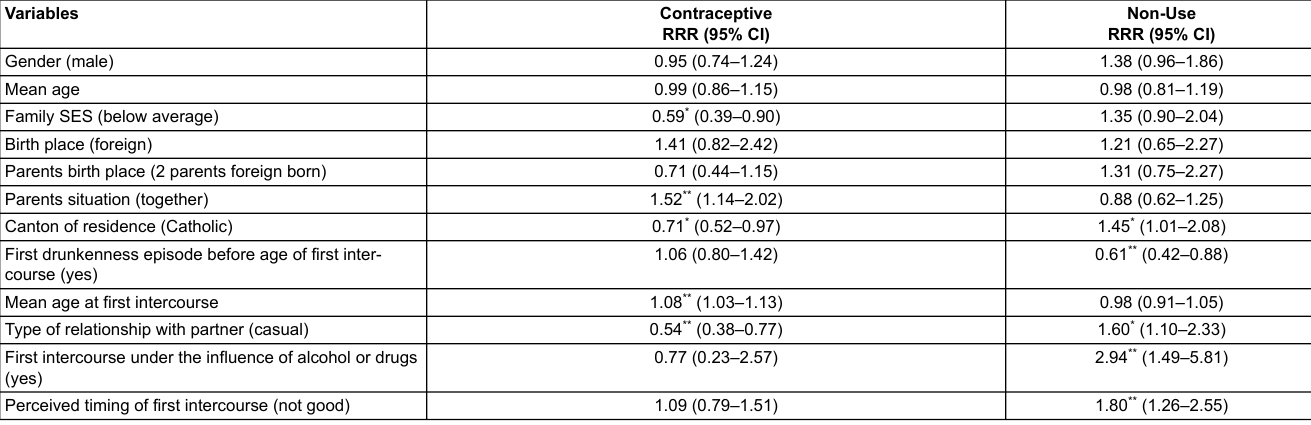
Table 2: Multivariate analysis of sociodemographic and personal characteristics by contraception used at first